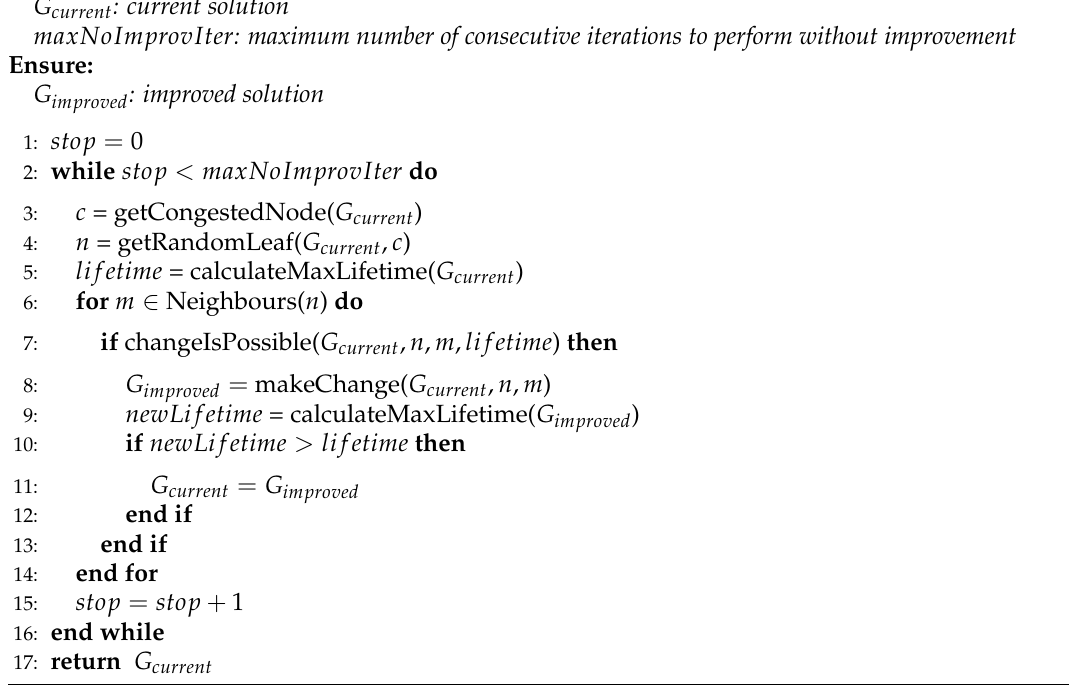
Algorithm 4 localSearch ( G current , maxNoImprovIter